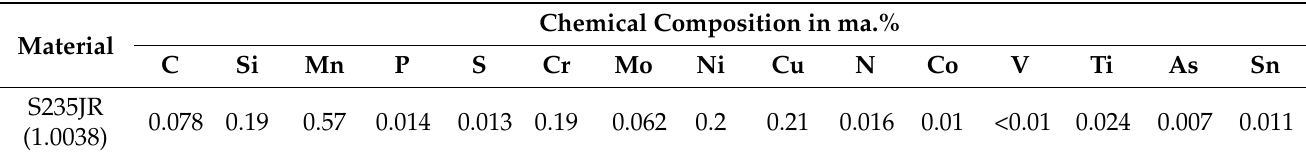
Table 3. Chemical composition of the material used for the experimental